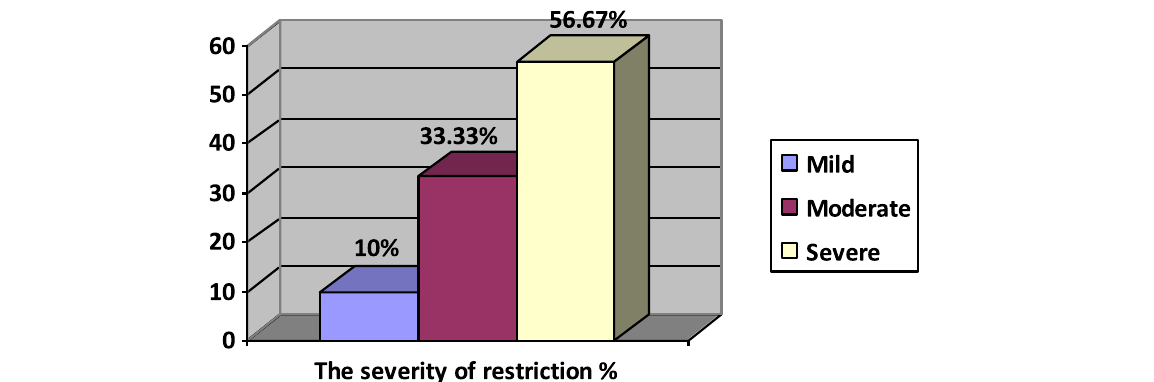
Fig. 1 The severity of restriction in the IIP group: mild, forced vital capacity (FVC) 60 – 80%; moderate, FVC 40 – 59%; and severe restriction, FVC less than 40%